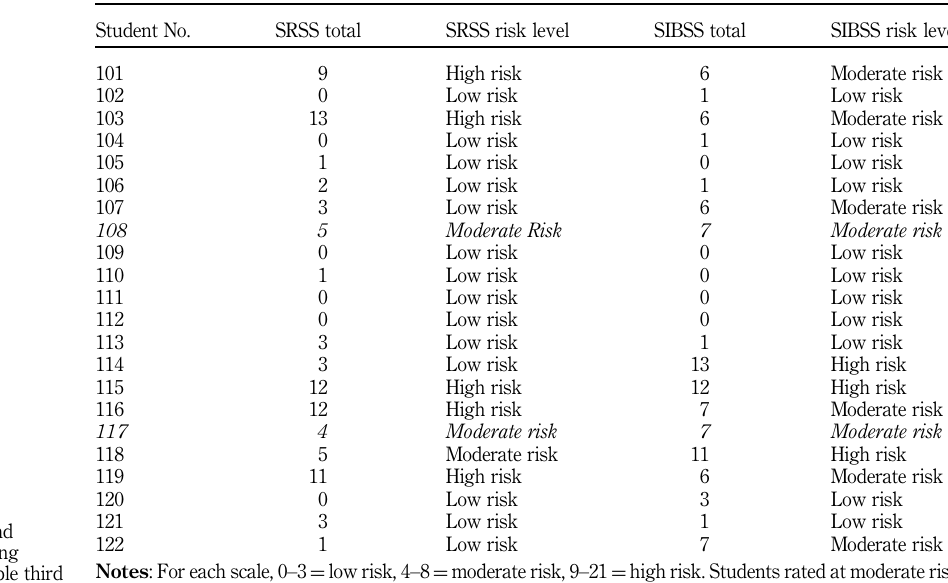
Table I. Fall SRSS and SIBS screening results (sample third grade